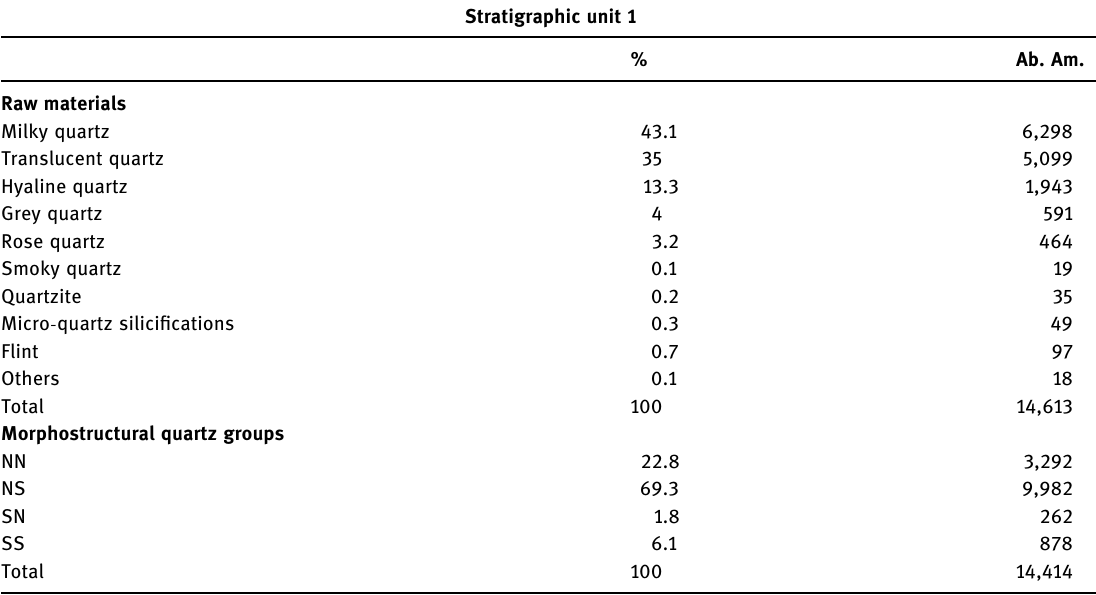
Table 1: General overview raw materials SU -